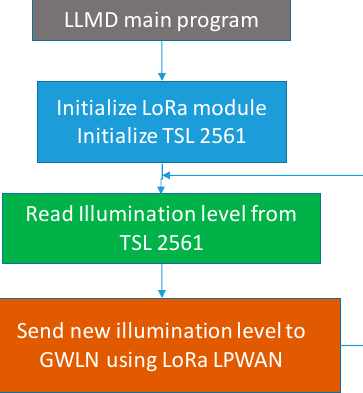
Figure 11. LLMD main program.